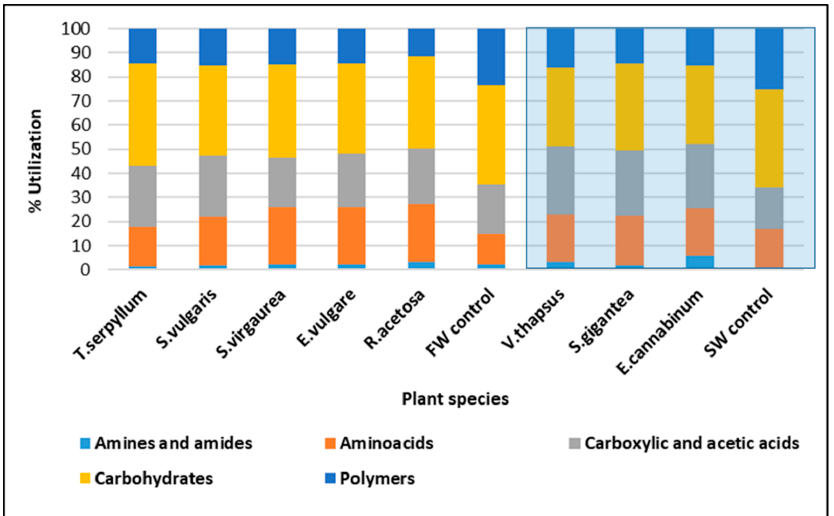
Figure 2. Average utilisation of groups of carbon substrates in FW and SW soils based on 144 h incubation ( n = 3). White background: FW; blue background: SW.